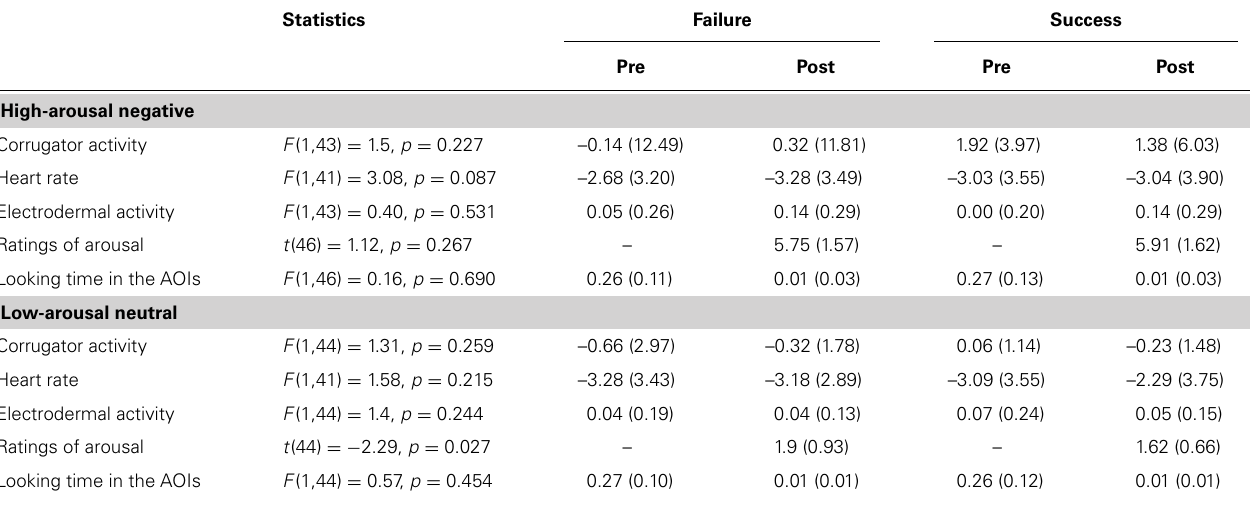
Table 1 | Mean (and Standard Deviations) for the dependent measures as a function of manipulated outcome and time in high-arousal negative and low-arousal neutral